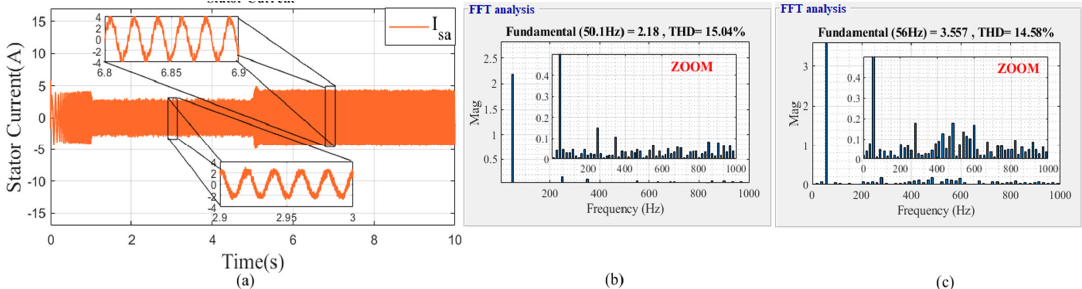
Figure 32. Performance with IR bearing defect of IM with DTC control: ( a ) Stator current and ( b ) THD at no ‐ load and ( c ) THD with load (5 Nm).